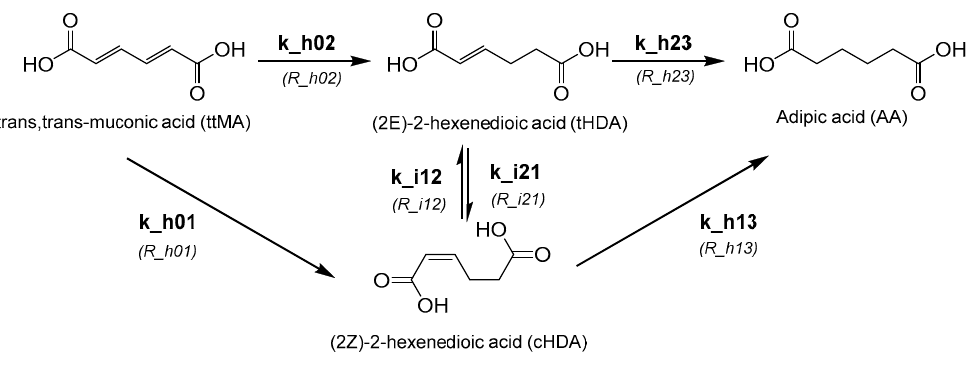
Figure 1. Reaction pathway of model LHHW_17P.